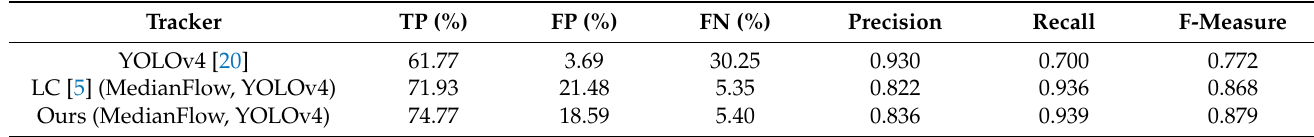
Table 5. Comparison of precision, recall, and F-measure on test